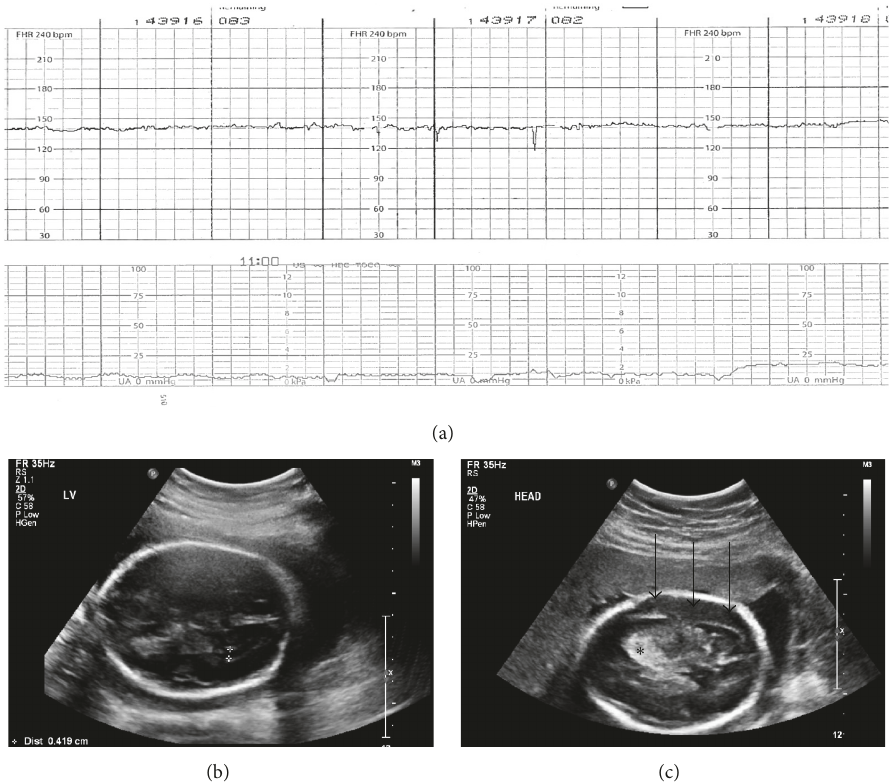
Figure1:Fetalheartrateandevolvingultrasoundfindingsfollowingfetalintracranialinjury.(a)Fetalheartrateshowedanormalbaselinewith persistent minimal variability and no accelerations or decelerations (b) 34 hours after trauma: fetal intracranial anatomy largely unremarkable as demonstrated by this transverse view at the level of the lateral ventricle. (c) 62 hours after trauma: a large hyperechoic lesion in the frontal lobe is visualized ( ∗ ) as well as findings consistent with a subdural hematoma (arrows).